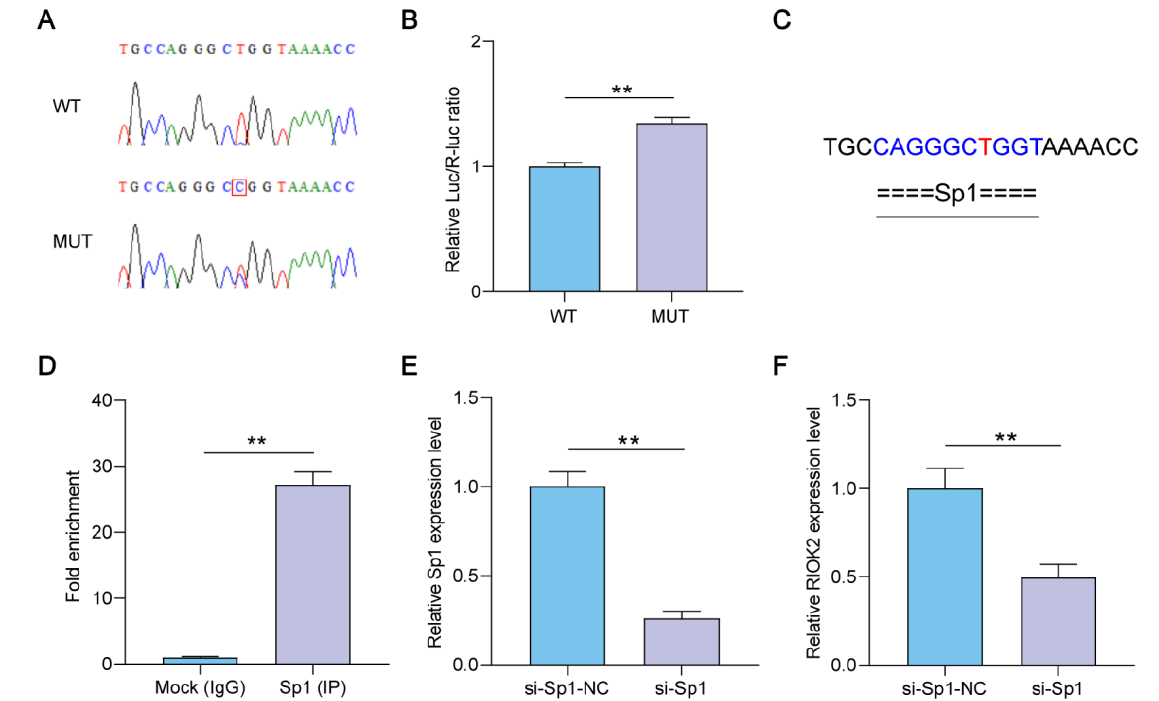
Figure 5. Sp1 activates the RIOK2 expression. ( A ) Sequencing plots of SNPs of the RIOK2 gene. WT means wild-type sequence and MUT means mutant sequence. The C/T mutation site is marked with a red box. ( B ) The dual-luciferase reporter gene assay was used to evaluate the effect of the mutation site on the RIOK2 promoter activity. ( C ) Prediction of Sp1 potential binding sites. The mutation site is highlighted in red. ( D ) ChIP-qPCR demonstrated that Sp1 could bind the promoter of RIOK2 . ( E ) Detection of Sp1 gene interference efficiency by qPCR. ( F ) The expression of the RIOK2 gene in IPEC-J2 transfected with si- Sp1 . Each experiment was replicated at least three times, and data are presented as mean values ± SD. ** p < 0.01.